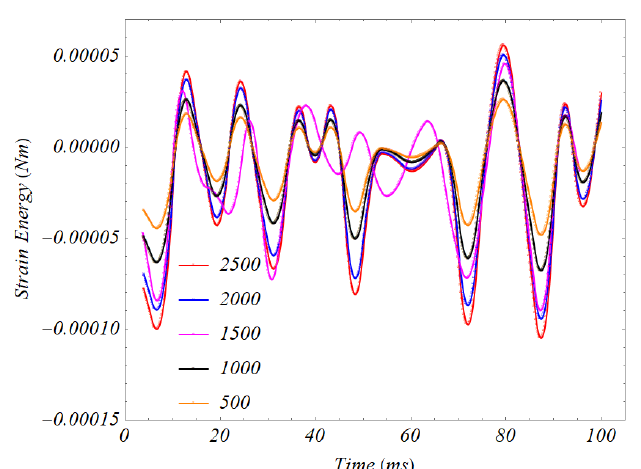
Fig. 15. Strain energy against time for various drop distances with a single phone